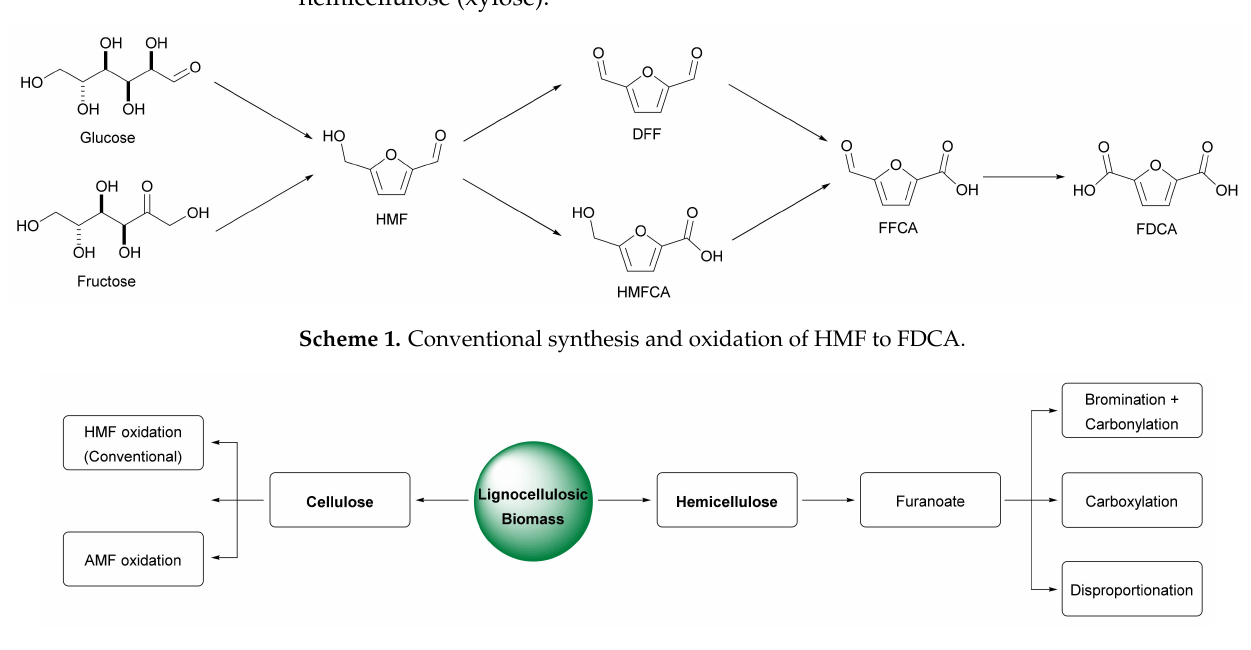
Figure 2. Alternative routes to 2,5-furandicarboxylic acid from lignocellulosic